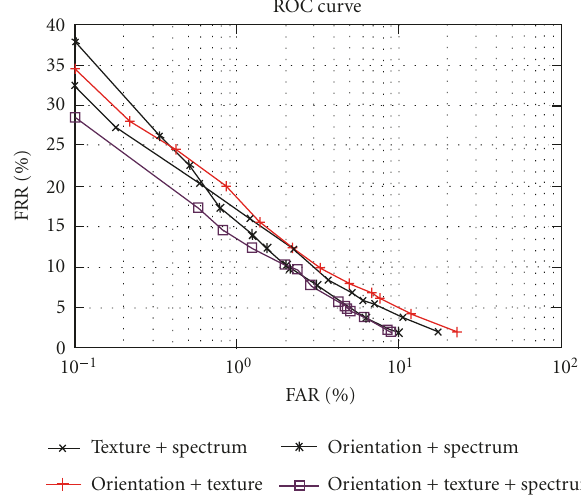
Figure 8: ROC curve for the decision-level fusion of features.